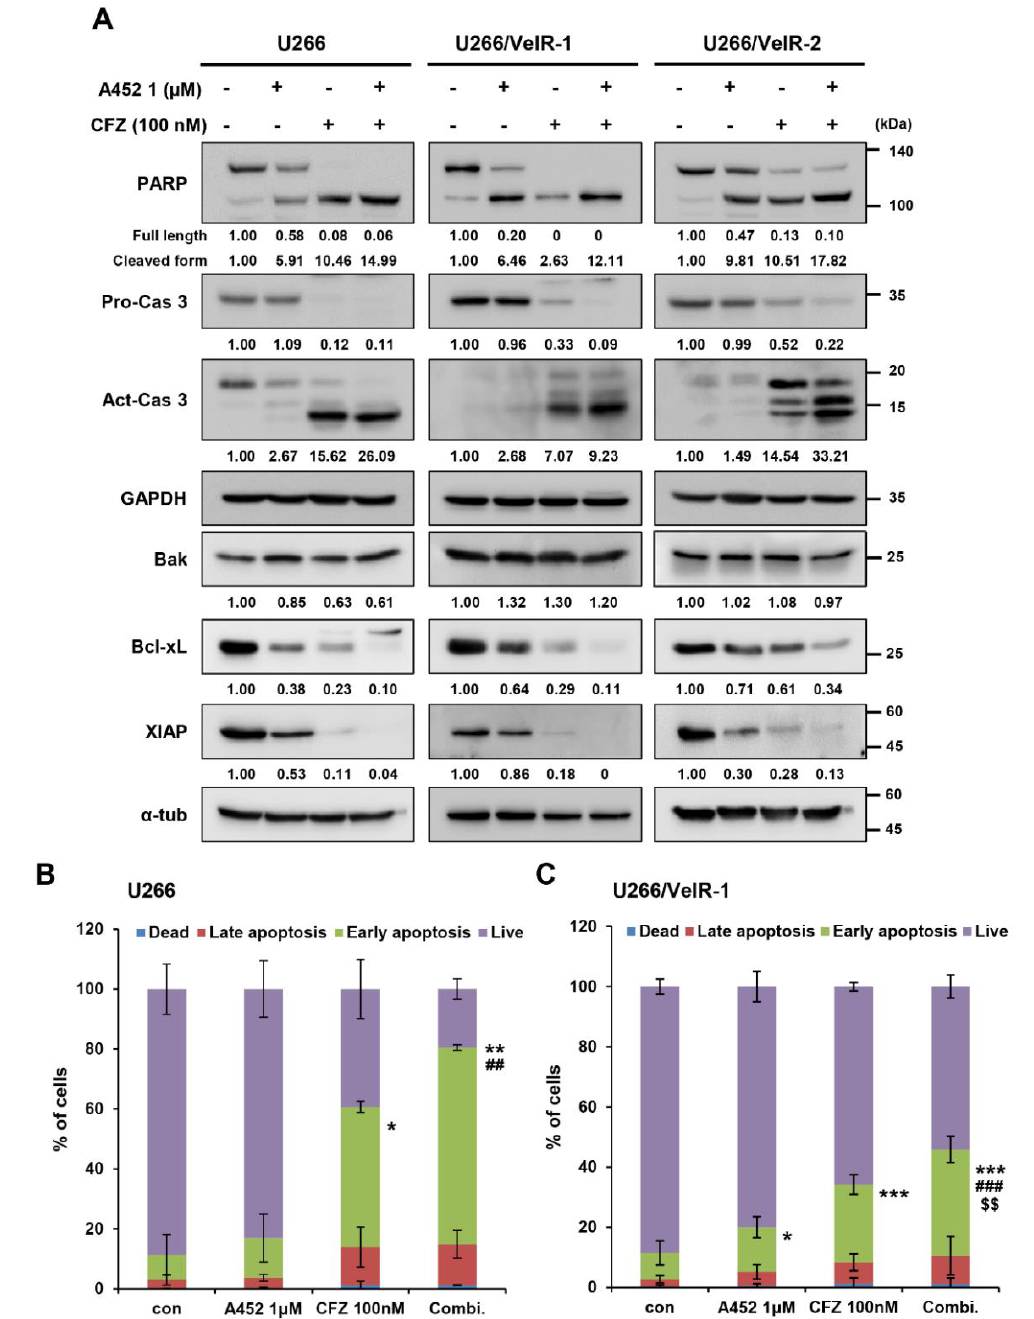
Figure 5. Cotreatment with CFZ and A452 leads to synergistic apoptosis induction in both BTZ-sensitive and BTZ-resistant U266 MM cells. ( A ) BTZ-sensitive U266 and BTZ-resistant U266 (U266/VelR-1 and U266/VelR-2) MM cells were treated with 0.1% DMSO (control), A452 (1 μM), and carfilzomib (CFZ) (100 nM) or in combination with these compounds as indicated for 24 h. Apoptotic markers were identified by immunoblotting using whole-cell lysates. Glyceraldehyde 3-phosphate dehydrogenase (GADPH) and α-tubulin were used as equal loading controls. The abundance of the indicated proteins was semi-quantified relative to GAPDH or α-tub; control levels were set at 1. ( B ) BTZ-sensitive U266 and ( C ) BTZ-resistant U266/VelR-1 MM cells were treated with 0.1% DMSO (control), A452 (1 μM), and CFZ (100 nM) or in combination with these compounds as indicated for 36 h. Cell death was assessed by flow cytometry and Annexin V/PI staining. Data present as mean ± SD ( n = 3). * p < 0.05, ** p < 0.01, and *** p < 0.001 vs. DMSO control; ## p < 0.01 and ### p < 0.001 vs. A452-treated group; $$ p < 0.01 vs. CFZ-treated group, two-way analysis of variance (ANOVA) test.